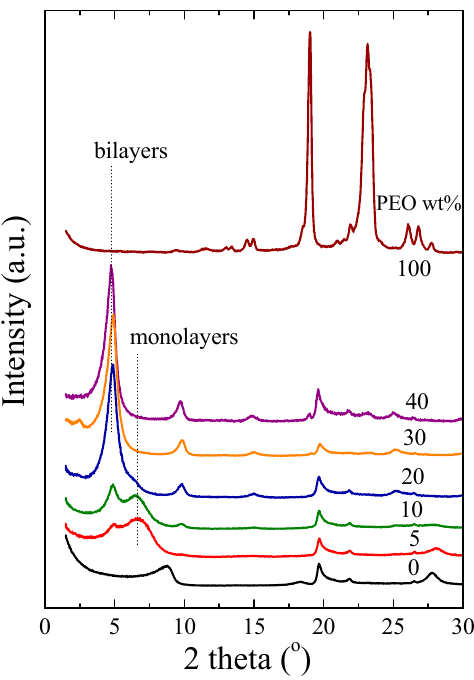
Figure 1. X-ray diffraction measurements of pure PEO, pure Na + -MMT, and PEO/Na + -MMT nanocomposites with 5–40 wt % PEO. The curves have been shifted for clarity.